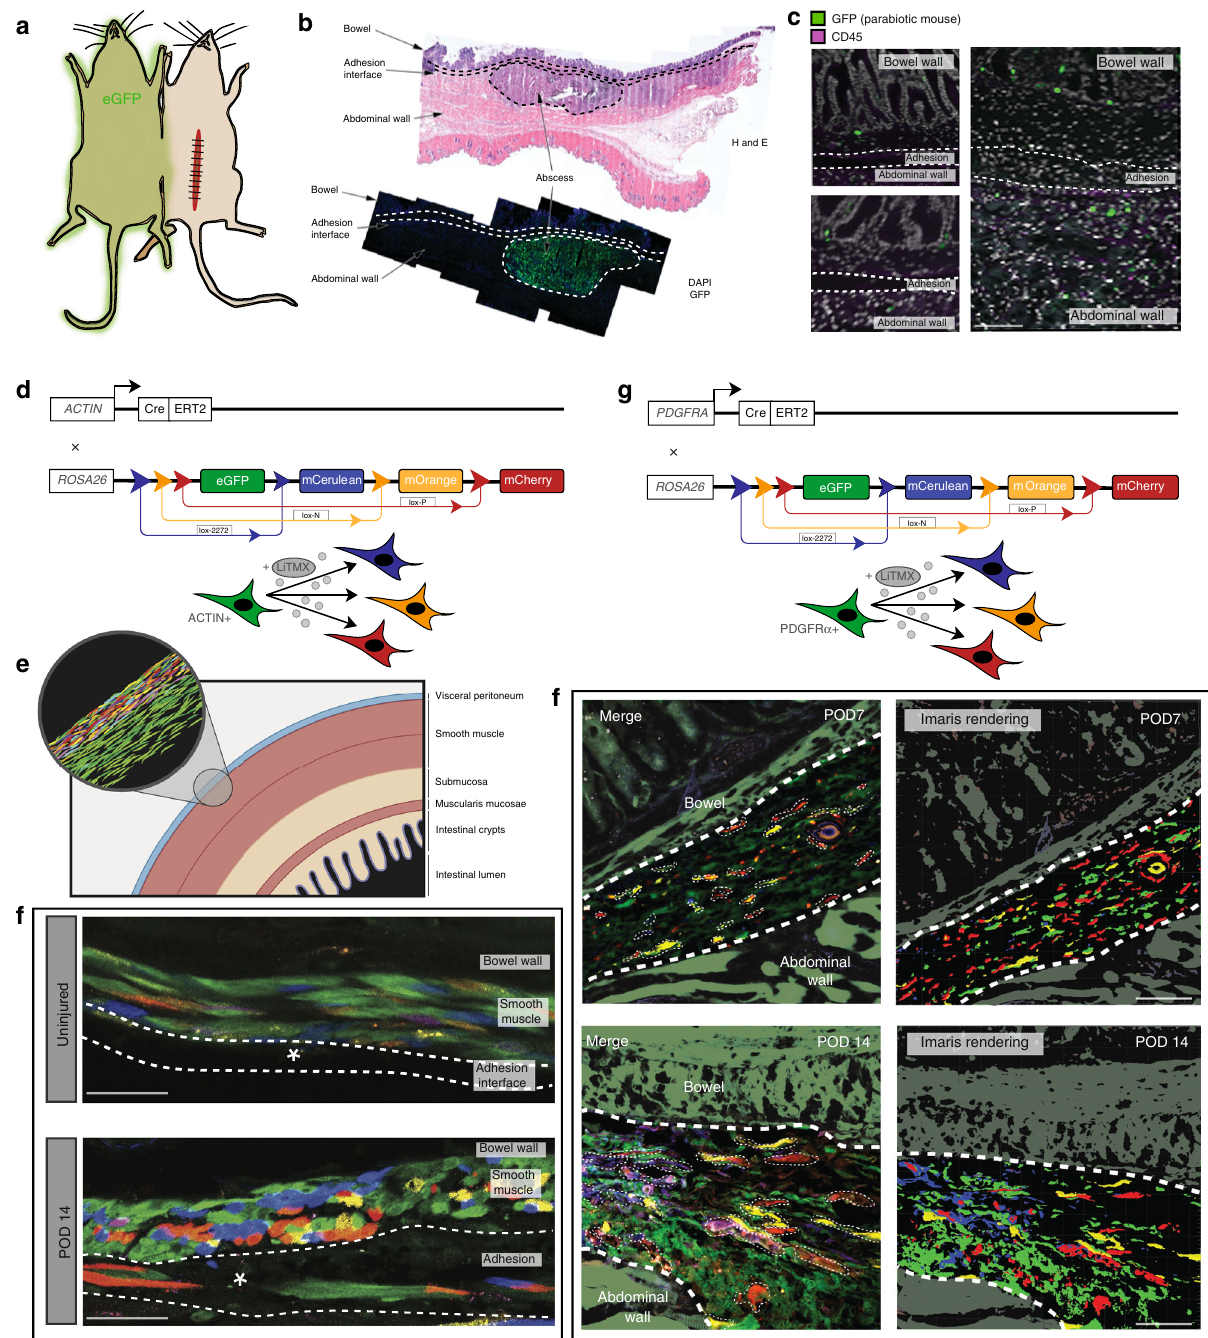
Fig. 2 Local fi broblasts proliferate polyclonally to form adhesions. a Parabiosis schematic. b H&E and IF data showing the presence of an abscess identi fi ed along the abdominal wall adjacent to the adhesion interface in a mouse parabiont, which is strongly GFP + (green fl uorescent protein) secondary to the presence of circulating immune cells in the abscess. c No GFP + cells were identi fi ed in the adhesion interface. Green (GFP) represents circulating cells, purple (CD45) stains for immune cells. n = 3 biological replicates. Scale bars, 50 μ m. d Schematic of the Actin CreER ::ROSA26 VT2/GK3 Rainbow mouse construct. e Schematic showing Actin CreER ::ROSA26 VT2/GK3 Rainbow mice locally induced with activated tamoxifen liposomes (LiTMX) at time of adhesion formation, using a published protocol 21 , ERT2 estrogen receptor T2. f Actin CreER ::ROSA26 VT2/GK3 Rainbow mouse uninjured control (top panel) and adhesion tissue harvested at POD 14 (bottom panel). Clonal proliferation of fi broblasts are visualized along the adhesion interface. Representative samples, structures as labelled in fi gures, white dotted lines outline adhesion, white asterisk marks adhesion interface, confocal imaging. n = 5 biological replicates. Scale bars, 25 μ m. g Schematic of the PDGFRA CreER ::ROSA26 VT2/GK3 Rainbow mouse construct. h Confocal imaging of representative PDGFRA CreER ::ROSA26 VT2/GK3 Rainbow mouse adhesion samples showing cellular clonality in the adhesion interface at postoperative day (POD) 7 (top panels, Imaris rendering at right), and POD 14 (bottom panels, Imaris rendering at right). Structures as labelled in fi gures, thick white dotted lines outline adhesion interface, thin white dotted lines outline individual clones, confocal imaging. n = 5 biological replicates. Scale bars, 50 μ